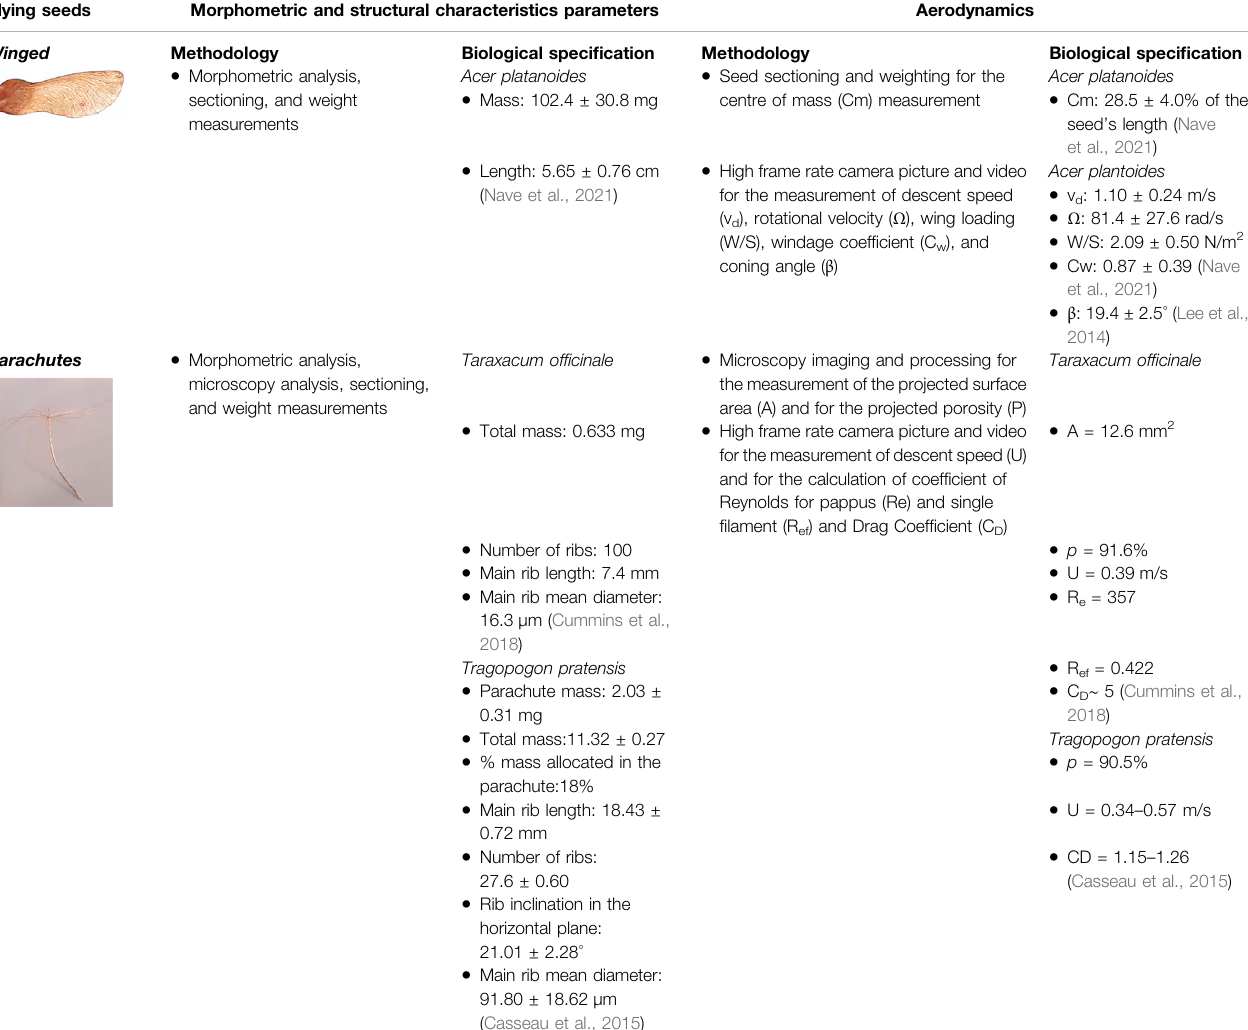
TABLE 2 | Summary of fl ying seeds biological features, measurements and characterization methods, and associated biological speci fi cations for soft robotic solutions. Flying